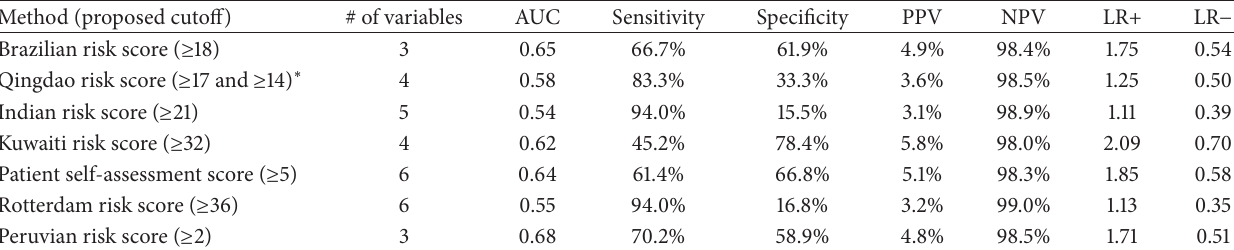
Table 4: Performance of different diabetes risk scores compared to Peruvian diabetes risk score using the CRONICAS study (validation sample).